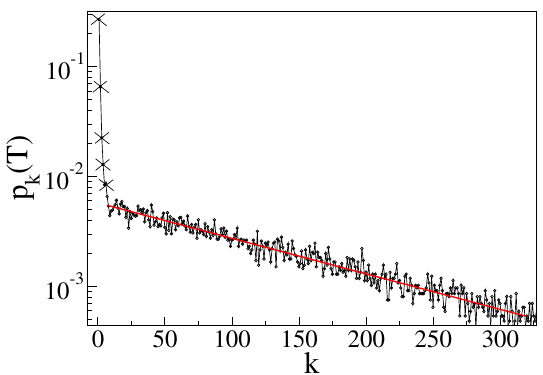
Figure 11: Distribution of the number of collisions a particle performs in a given potential well before escaping. The peak form for small k values is associated to the particles that exit from a well before thermalizing into it. Thermalization is seen to occur after k (cid:39) 6 collisions. Parameters: ∆ U = 1 / 4, L = 2, T / ∆ U = 0.21 and ω